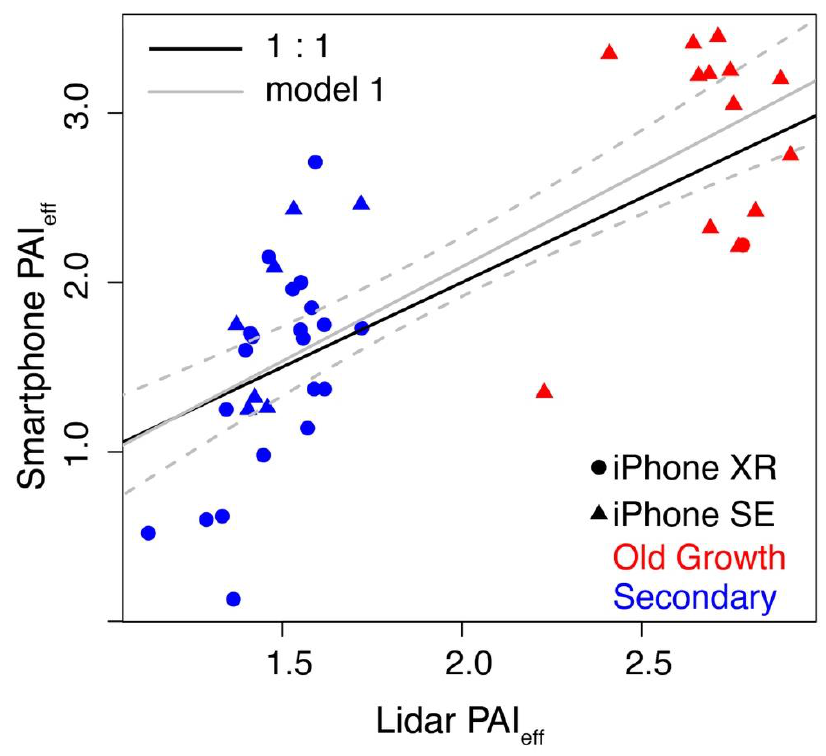
Figure 4. Relationship between smartphone and lidar PAI eff , using the four-ring smartphone PAI eff estimation method and optimal values for lidar radius (25 m) and leaf angle distributions (spherical for old growth, planophile for secondary). Dashed lines show the 95% confidence interval around model 1. Table 3. Comparison among models to explain variation in smartphone PAI eff. All models were fit using all 42 observations of smartphone and lidar PAI eff at La Selva. All ΔAIC values are relative to model 1. Values for r 2 are the adjusted r 2 values for each linear model.